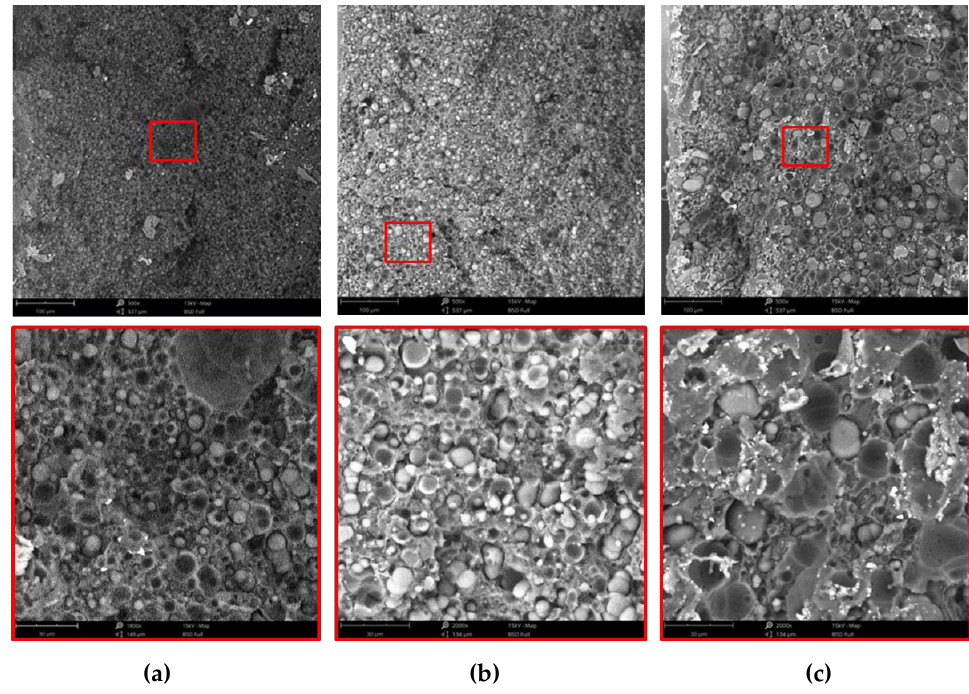
Figure 3. SEM micrographs: ( a ) A3, ( b ) C2 and ( c ) D1 .